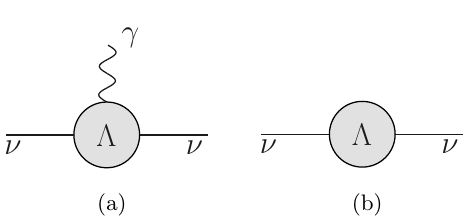
Figure 3 . The Feynman diagrams for the NMM and the radiative neutrino mass induced by new physics below the electroweak